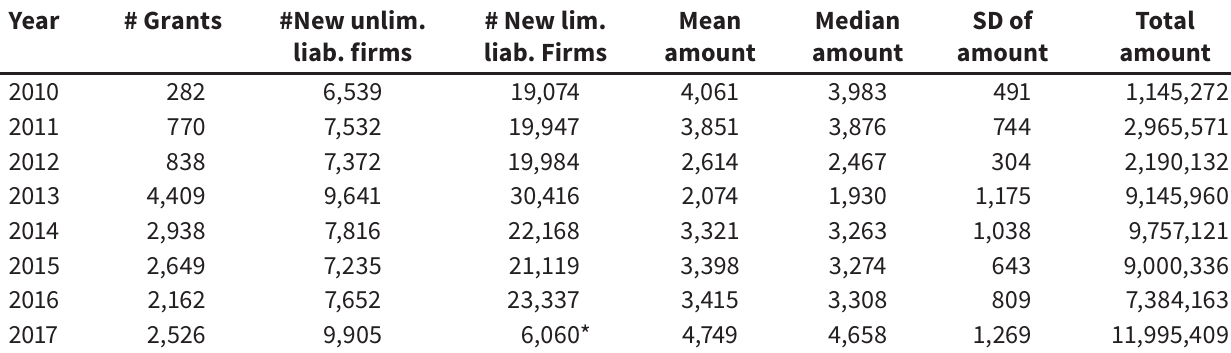
Descriptive statistics on self-employment grants (in